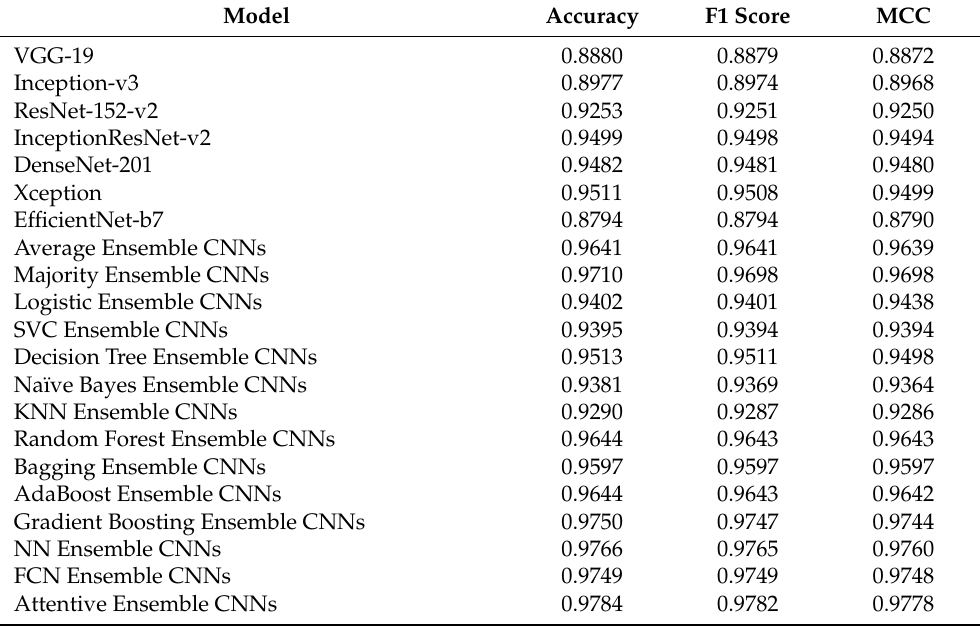
Table 6. Evaluation Metrics on Chinese CT Scan database.